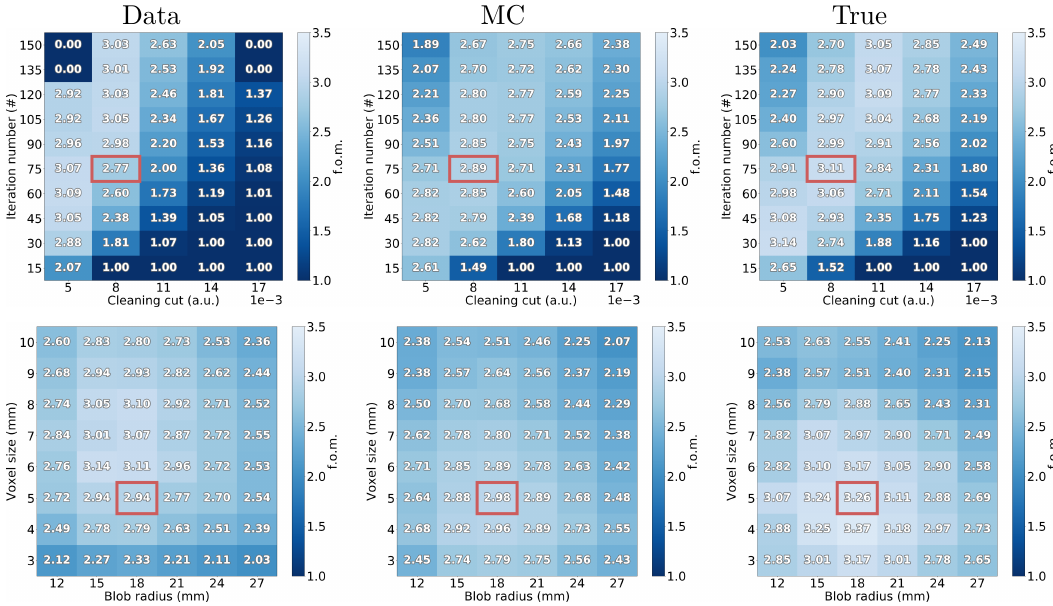
Figure 18 . Parameter scan for optimizing the figure of merit, equation (5.3), for events in the double escape peak ROI for data, MC using the fitting procedure, and MC using the true information (i.e., whether the event contains a positron or not). The result for the optimal configuration is marked in red. Top row: maximal figure of merit for different combinations of the number of RL deconvolution iterations and the final threshold for the cleaning cut, keeping a voxel size of 5 mm and blob radius of 21 mm. Bottom row: maximal figure of merit for different combinations of voxel size and blob radius, for 75 RL iterations and a cleaning cut of 0.008. The SiPM charge cut is 10 PE in all